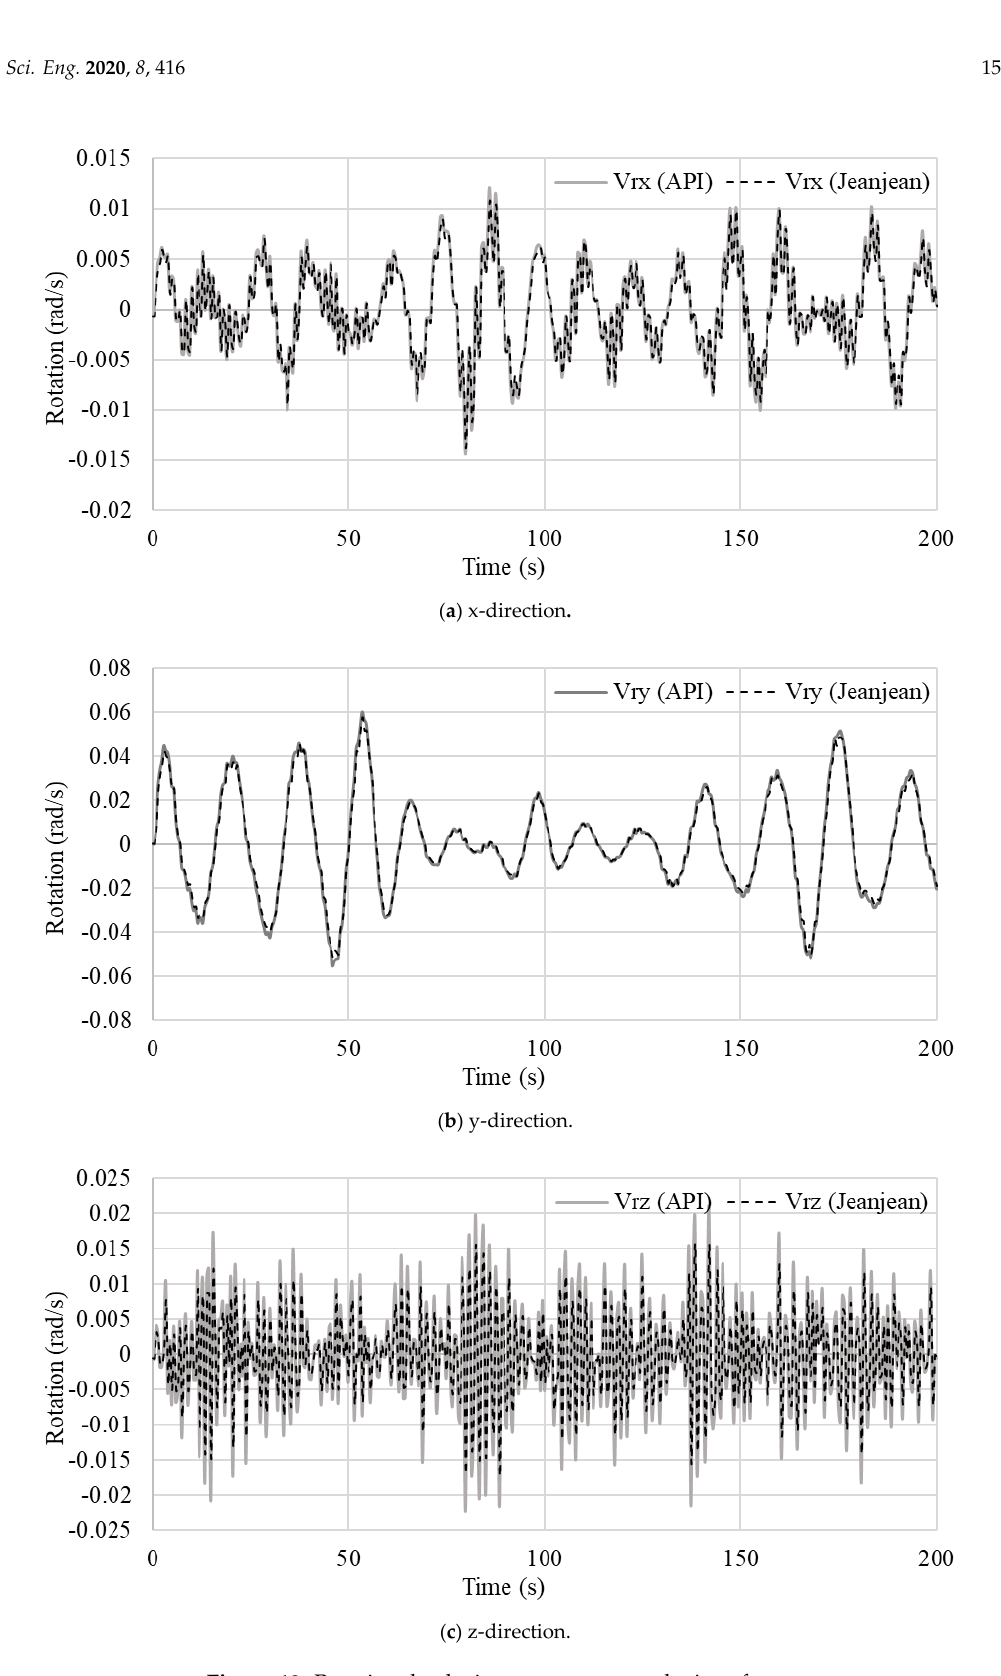
Figure 18. Rotational velocity components at the interface.